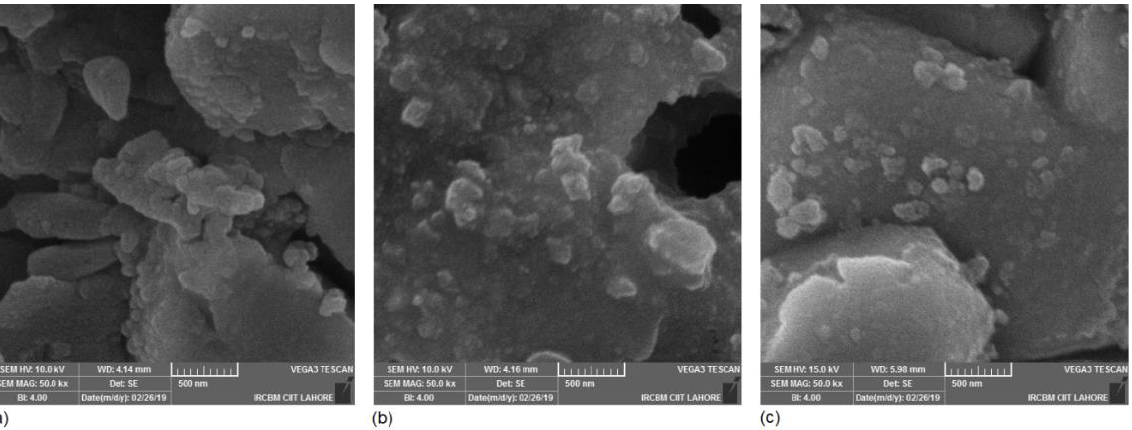
Figure 2. Scanning electron microscopy (SEM) images ( a ); LCZ-pure; ( b ) 1 wt.% Gr-LCZ; ( c ) 1.5 Figure 2. wt.% Gr-LCZ.